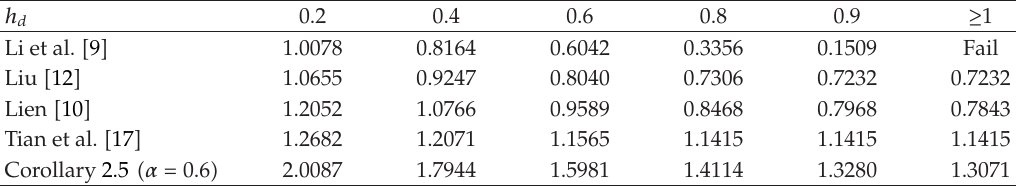
Table 1: Computation MADB h for varying h d in Example 3.1.